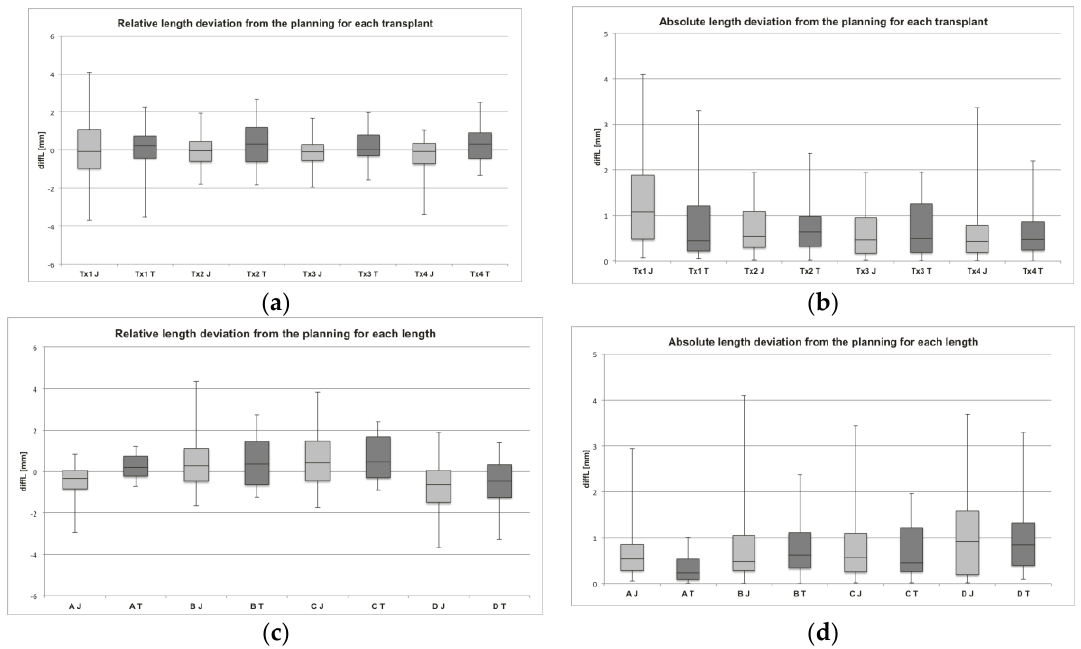
Figure 6. Assessed length deviations. In ( a ) and ( b ), the relative and absolute deviations from the original planning parameters are shown for each transplant (Tx1 – Tx4) separately for both methods (J: MUC-Jig, T: template). In ( c ) and ( d ), the relative and absolute deviations from the original planning parameters are shown for each measured section (A – D) separately for both methods (J: MUC-Jig, T: template).